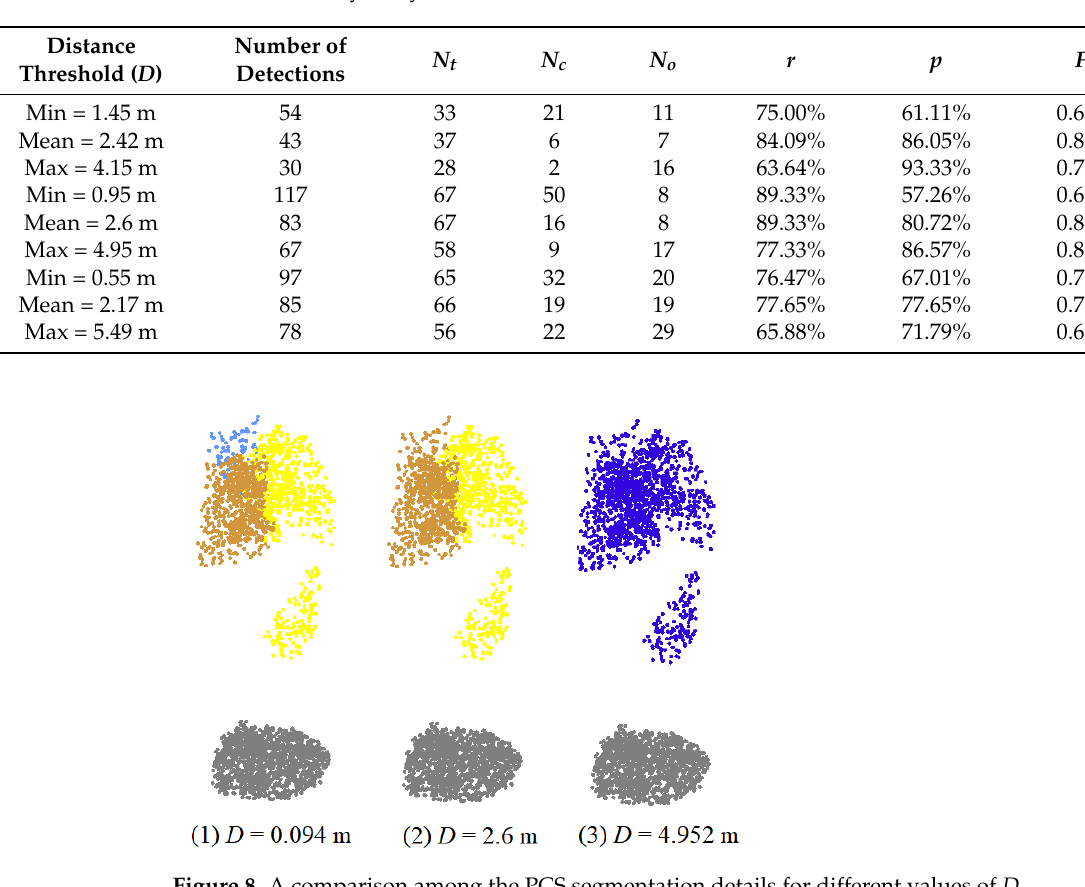
Table 4. Sensitivity analysis of the LS method.